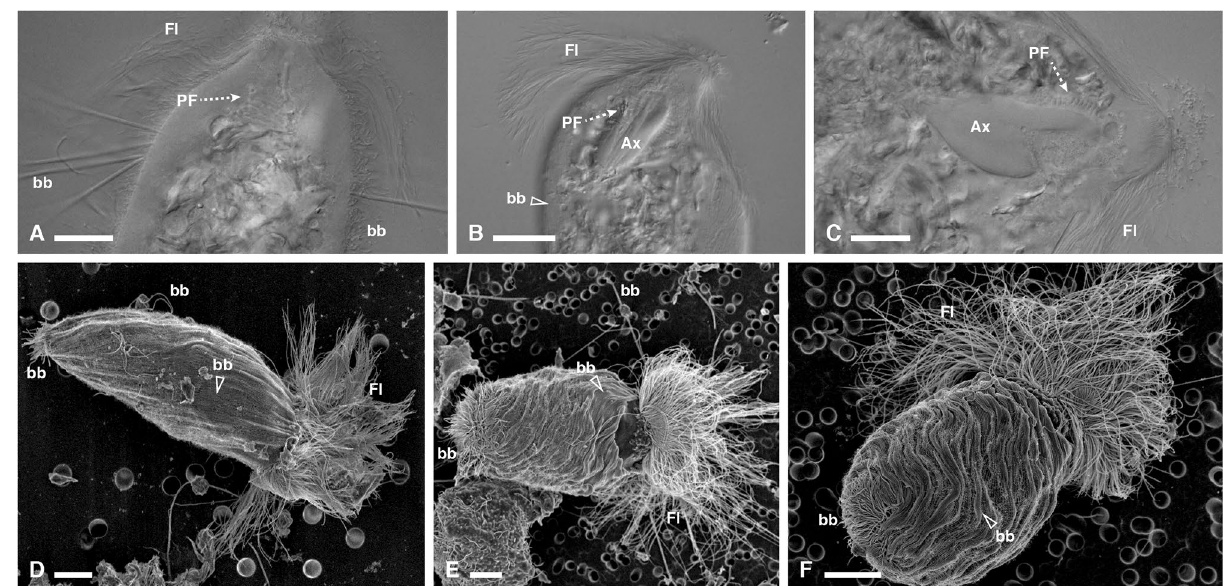
Figure 3. Light and electron micrographs of R. illapa specimens . ( A – C ) DIC and ( D – F ) SEM images of Runanympha illapa specimens from Comatermes perfectus showing the overall body shape, with the flagella, surface bacteria, axostyle, and spiralized parabasal fibers. Fl flagella, bb bacteria, Ax axostyle, PF parabasal